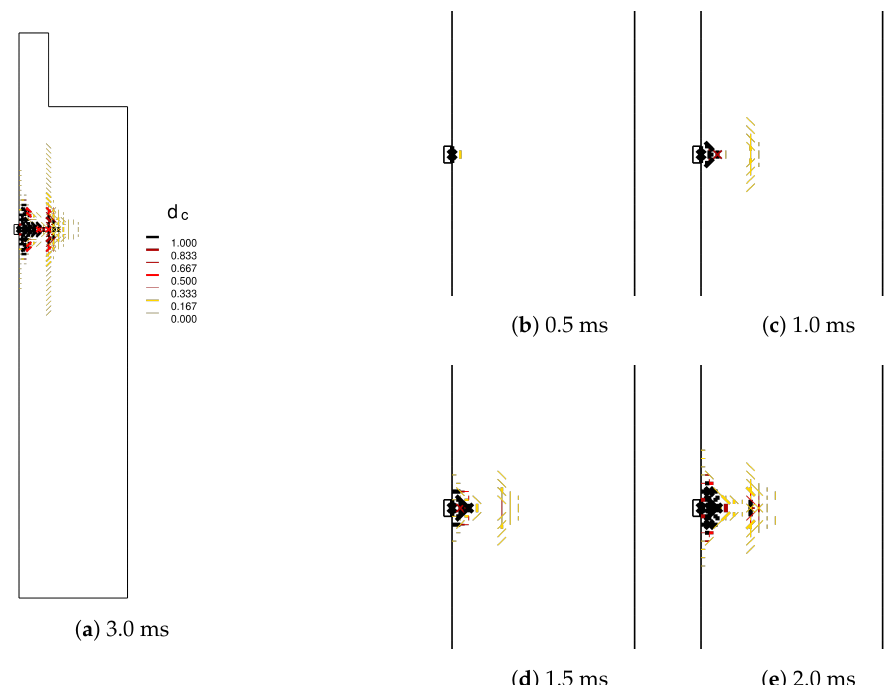
Figure 13. Maps of the compressive spring damage ( d c ) and zoom on the impact point at different points in time.